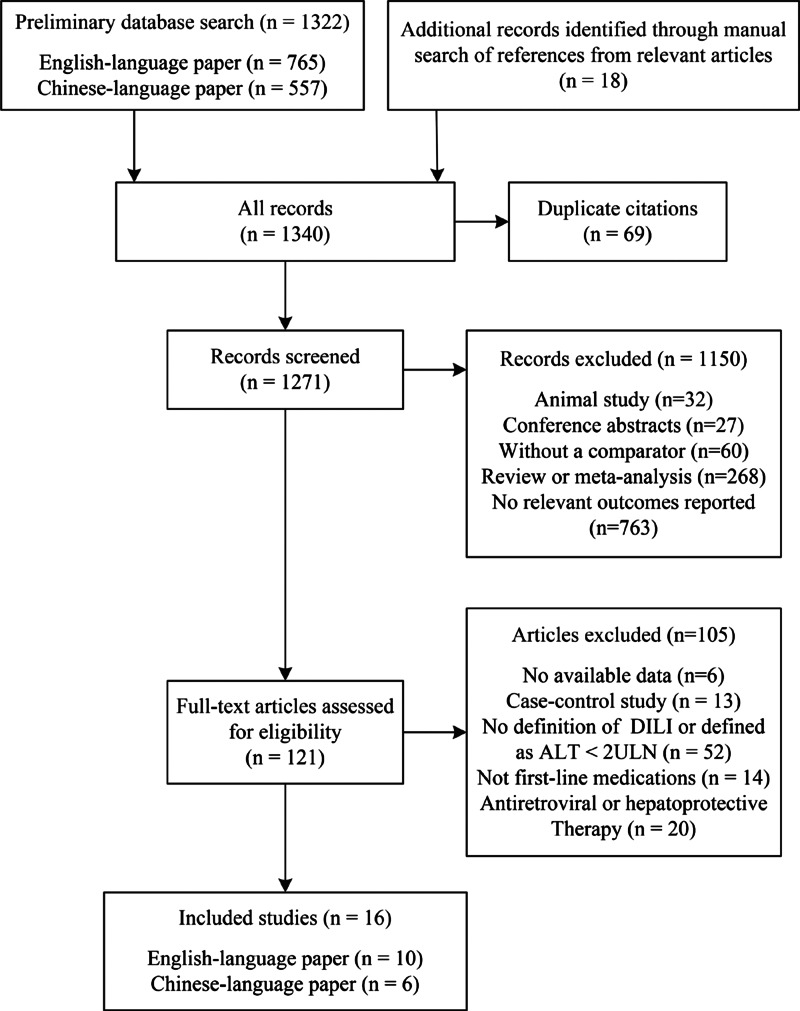
Flow diagram of the study selection process.